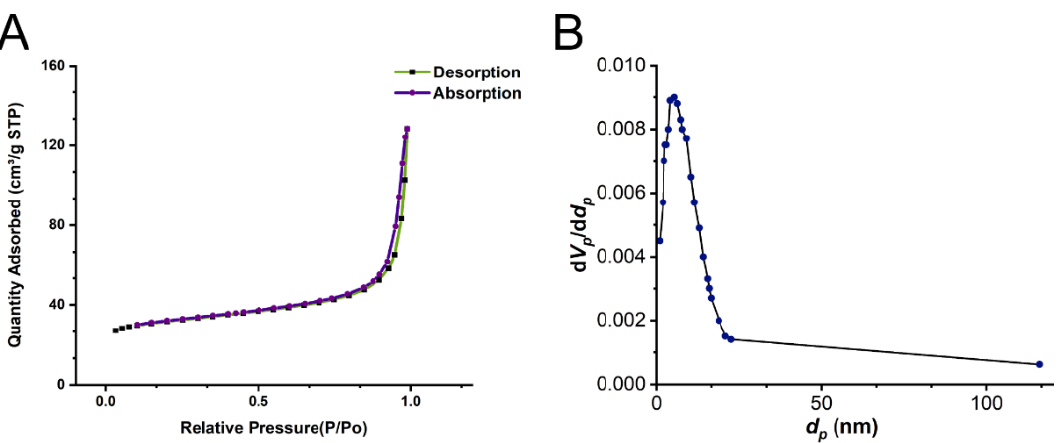
Figure 5. Brunauer–Emmett–Teller (BET) of IRMOF-10: ( A ) N 2 adsorption and desorption isotherm of IRMOF-10; ( B ) pore size distribution of IRMOF-10.